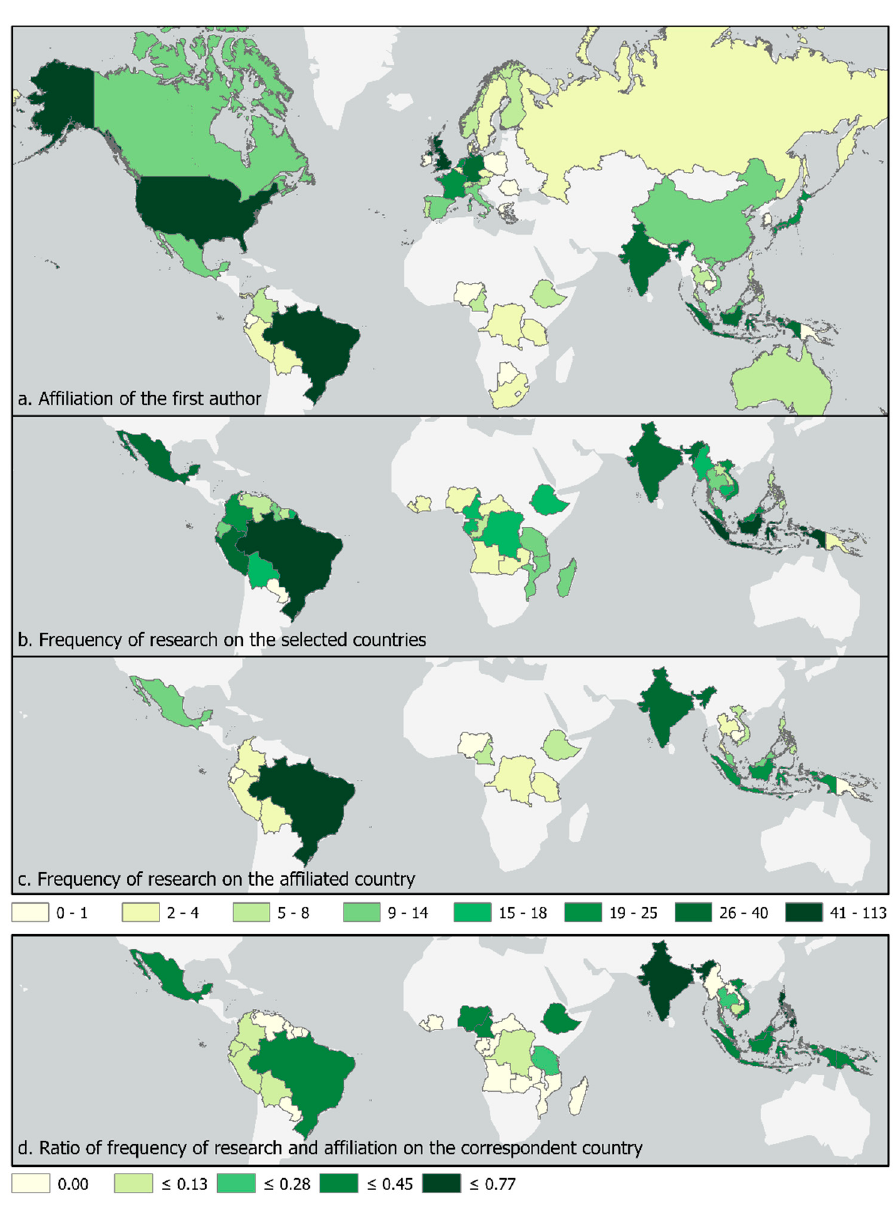
Figure 5. Classification of the studies regarding the country of affiliation of the first author, the frequency of research in the 35 selected countries, the frequency of research in the country where the first author was also affiliated and the ratio between the frequency of research and frequency of affiliation.